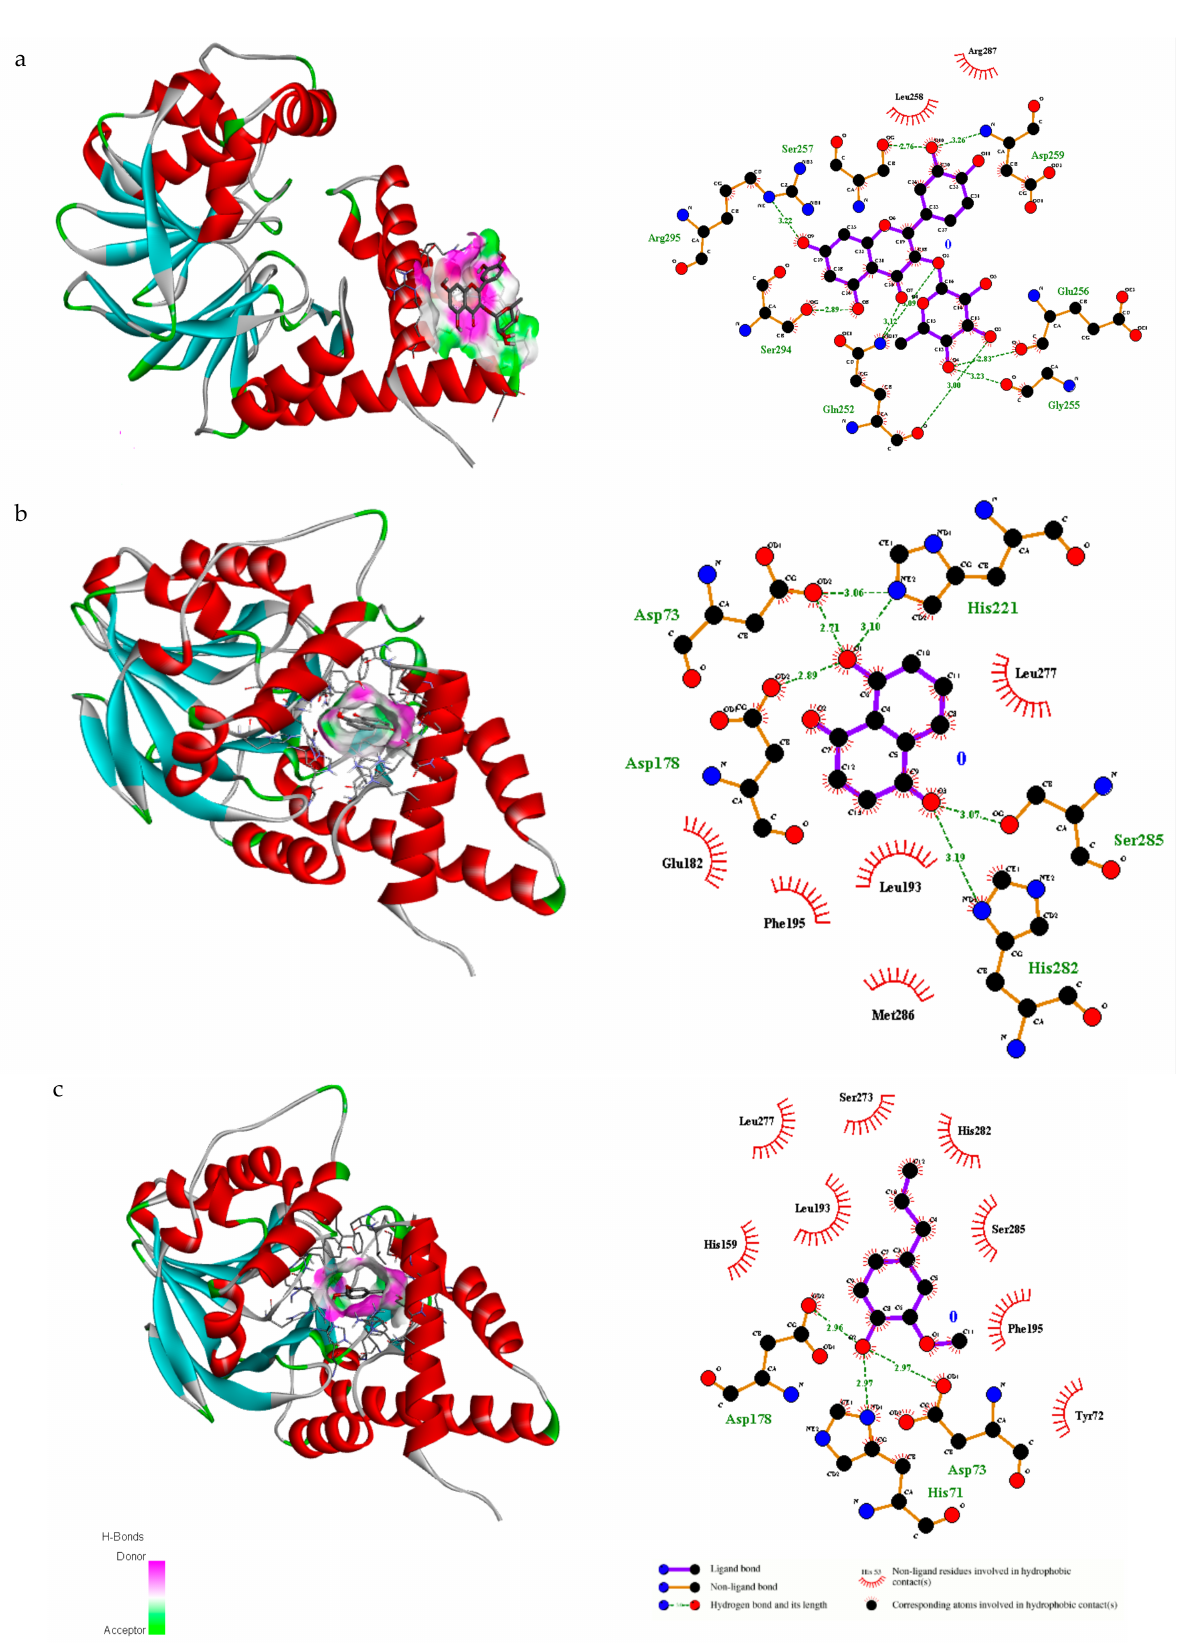
Figure 1. 3D interaction and H, non-H bonding interactions of ( a ) querccitrin (pose 1) ( b ) juglone (pose 1) and ( c ) eugenol (pose 2) inside binding sites of transcriptional regulator